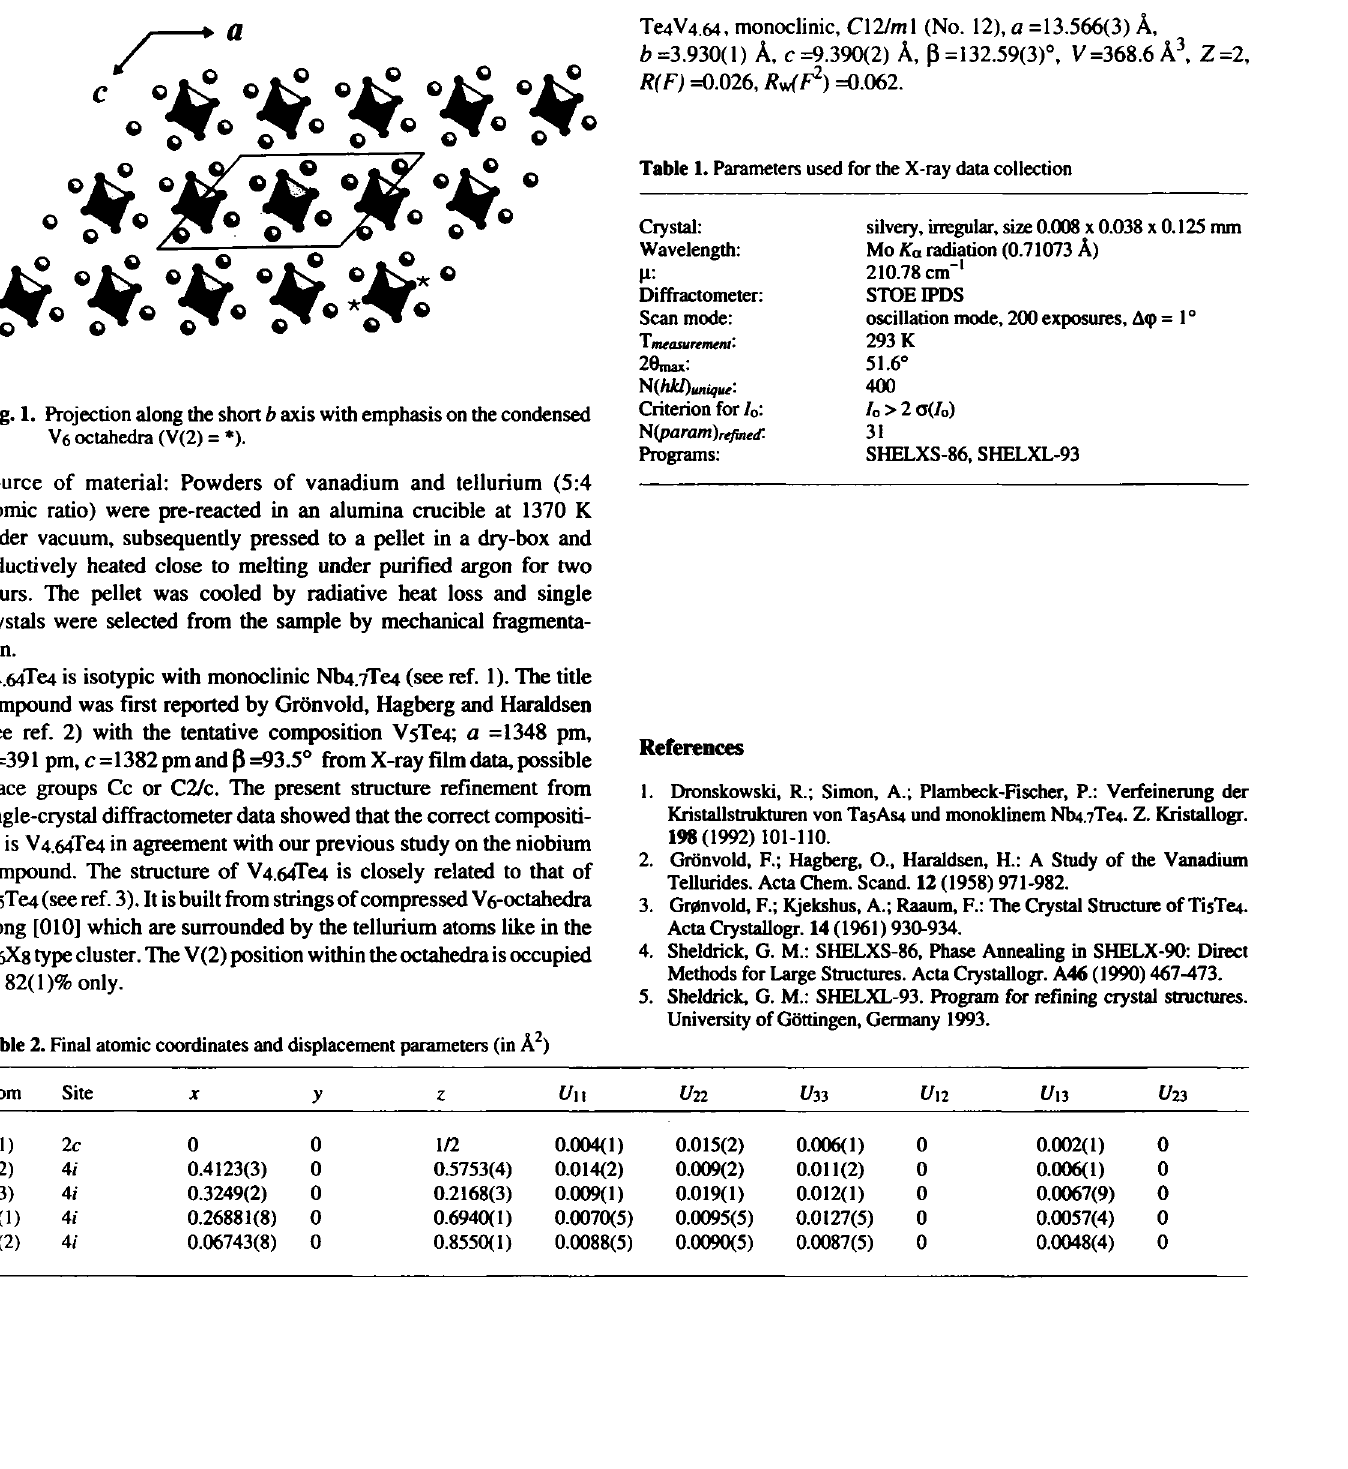
Table 1. Parameters used for the X-ray data collection